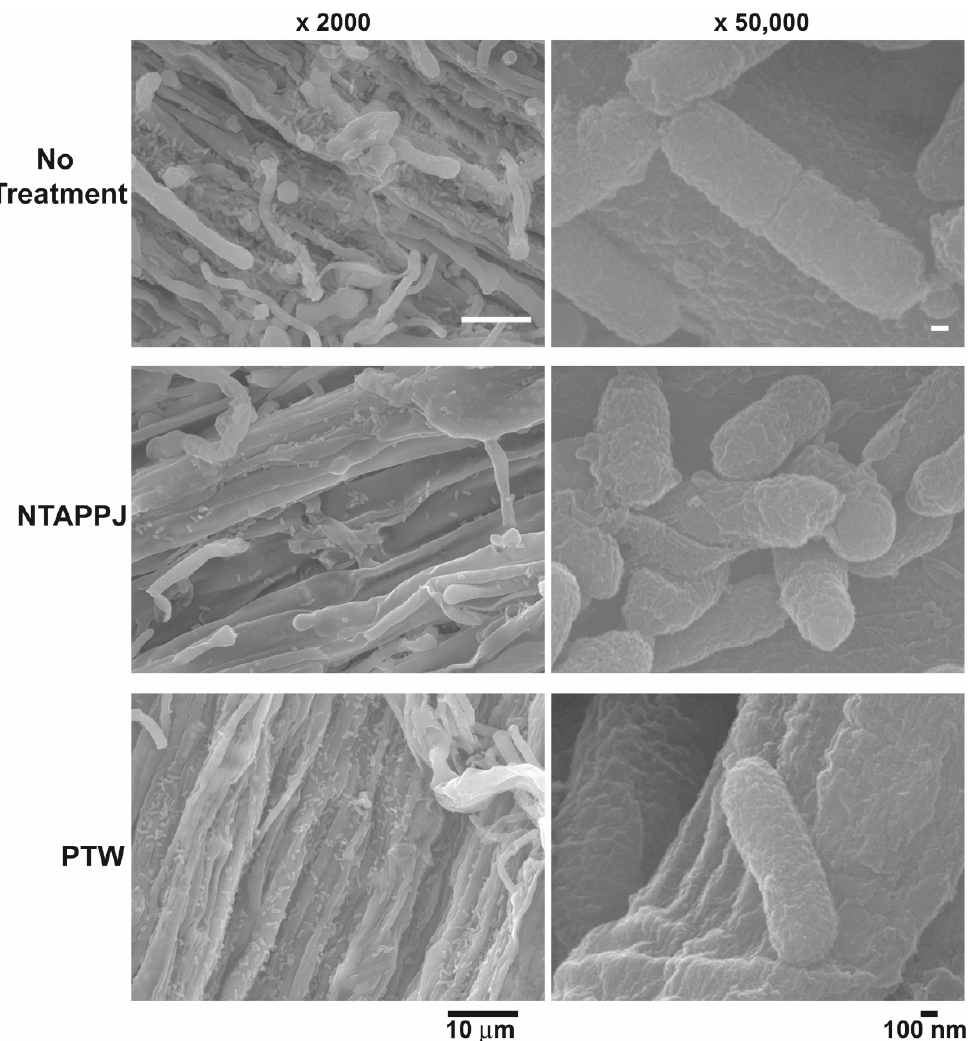
Figure 3. SEM images of the surface of mushroom treated with NTAPPJ and PTW after inoculation with E. coli .